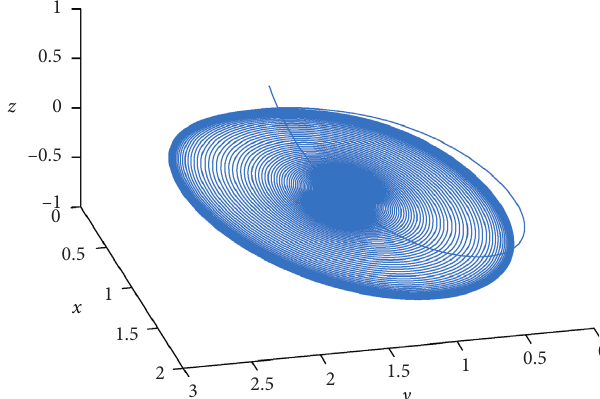
Figure 16: Dynamic behavior of fractional financial chaotic model with α � 0 . 95.